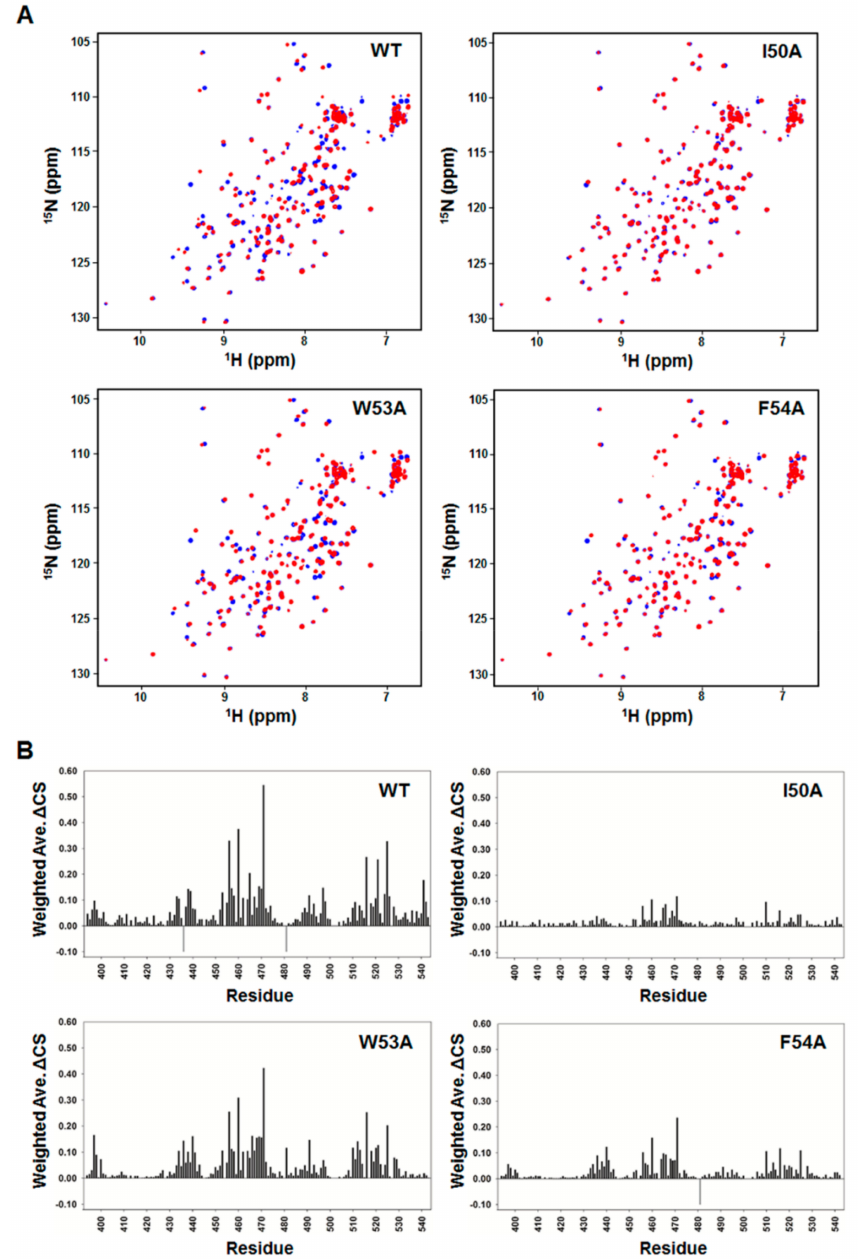
Figure 5. Mutational analysis on p53TAD binding to MED25 ACID; ( A ) Overlay of 2D 1 H- 15 N HSQC spectra of 15 N-labeled MED25 ACID in the absence (blue) or presence (red) of wild-type p53TAD2 peptide and mutant p53TAD2 peptides (I50A, W53A, and F54A) at a molar ratio of 1:1; ( B ) Chemical shift perturbations on MED25 ACID induced by binding to wild-type and mutant p53TAD2 peptides (I50A, W53A, and F54A) at a molar ratio of 1:1. Weighted ∆ CS values were calculated as described in Materials and Methods. Resonances that disappeared upon binding are shown as negative gray